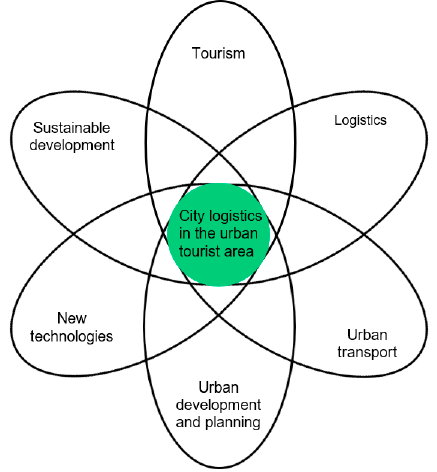
Figure 5. Dominant subfields in the research area of city logistics in the urban tourist area.